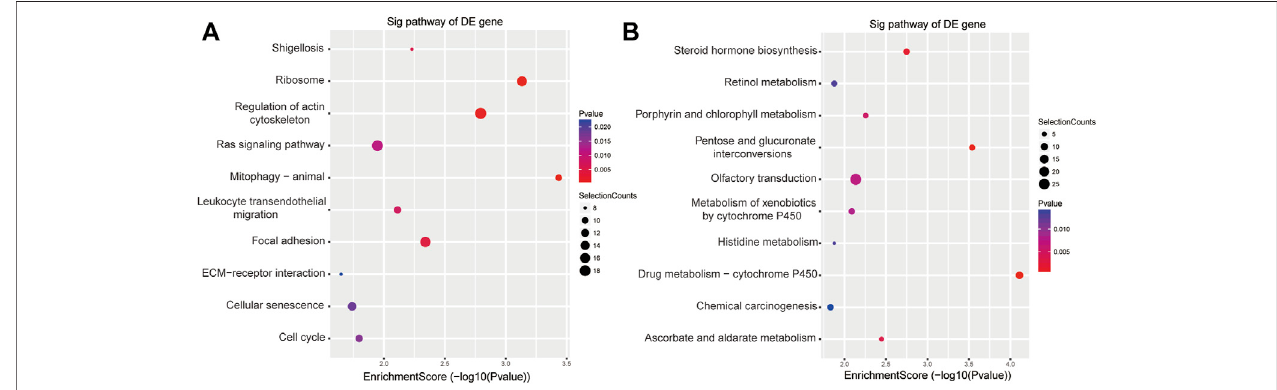
FIGURE 3 | KEGG analyses of the DE genes among ischemic stroke patients versus non-stroke controls. KEGG terms for the DE upregulated (A) and downregulated genes (B)